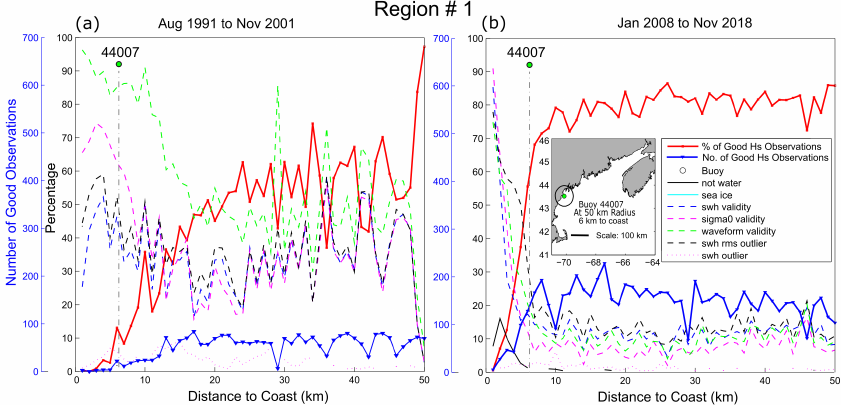
Figure 2. Total number of observations per 1 km bin, and proportion of data associated with good quality and rejection flags, as a function of distance to the coast, for region #1 on the north east U.S. coast. The ( a ) first 10 years and ( b ) last 10 years of the Sea State CCI L2P satellite record are